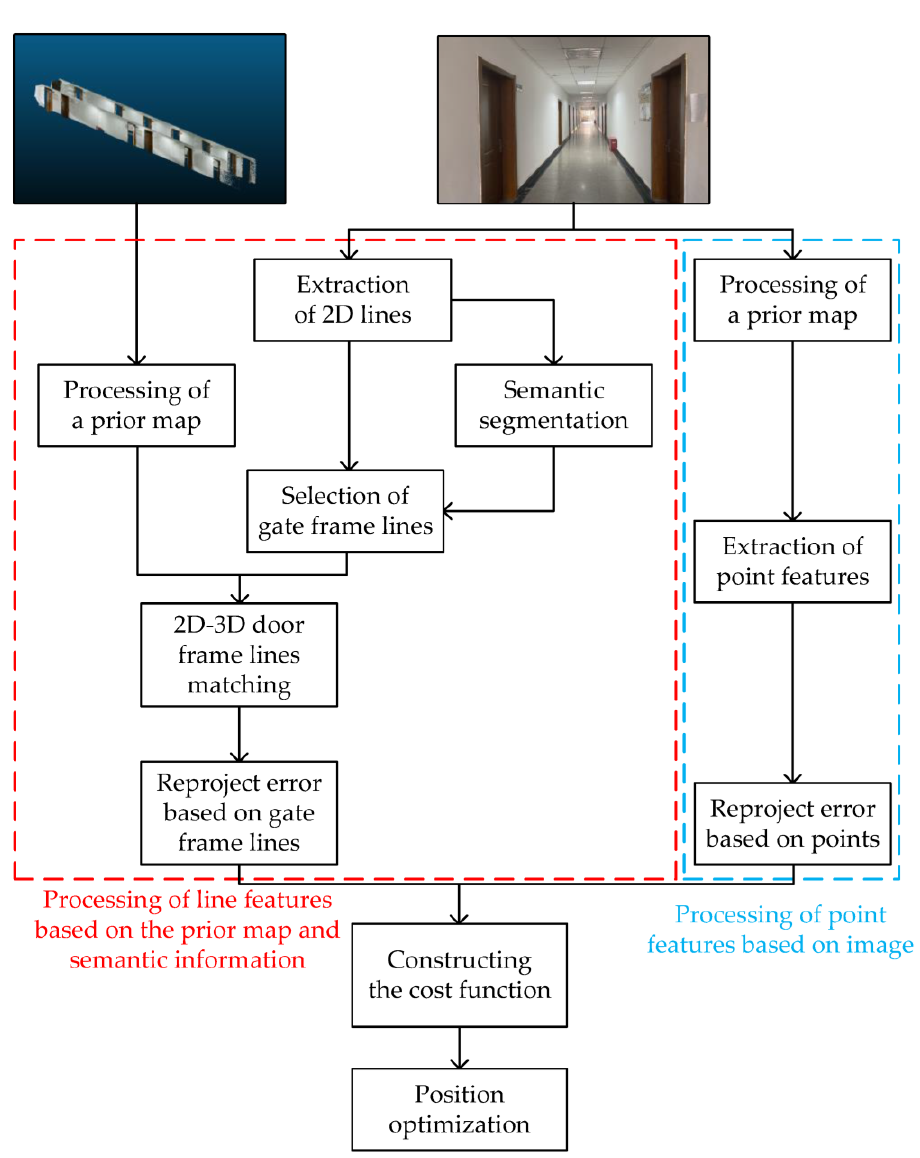
Figure 3. Block diagram of the proposed indoor location algorithm.